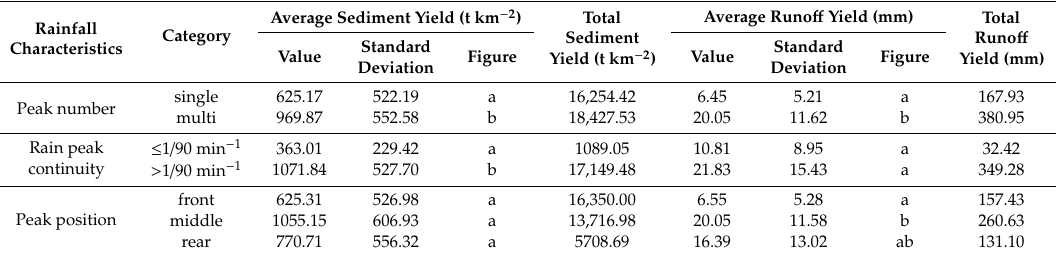
Table 2. Runo ff and sediment yield under di ff erent peak numbers, peak positions, and peak continuities. Rainfall